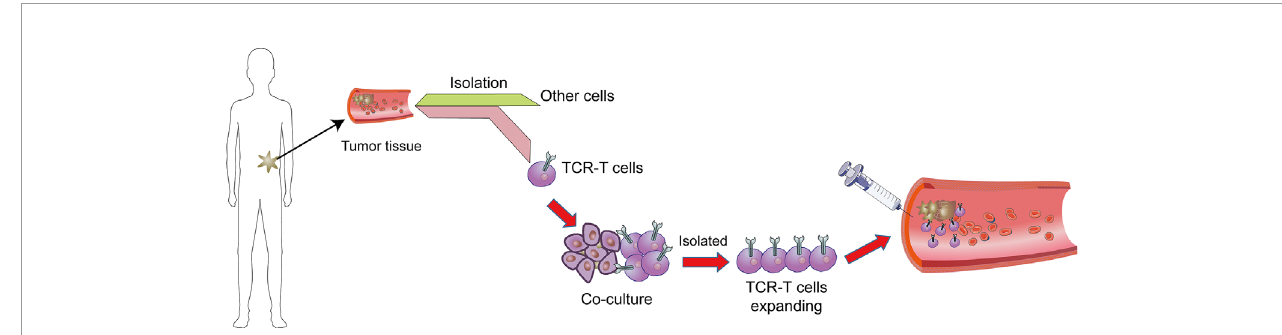
FIGURE 1 | Adoptive T cell therapy. In adoptive cell therapy (ACT), cells are collected from cancer tissues/T cells which are then isolated from other cells, genetically manipulated by engineered TCR or CAR, co-cultured and proliferated, and eventually sent back into circulation.